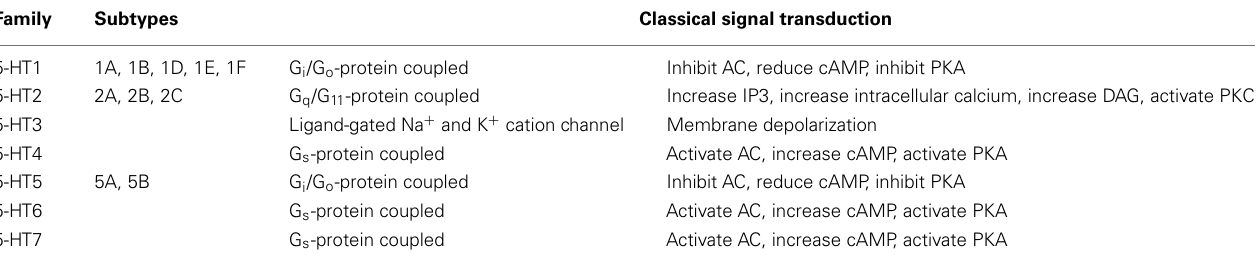
Table 1 | Serotonin